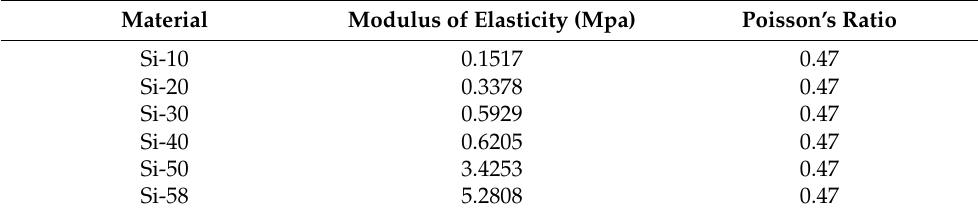
Table 1. Material properties of silicon rubbers that used in the simulation.